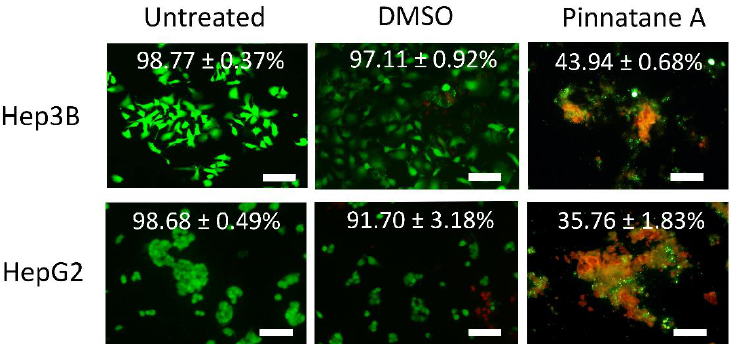
Figure 2. Pinnatane A induces cell death in Hep3B and HepG2 cell lines. A live/dead assay after treatment with pinnatane A and DMSO for 12 h. Green fluorescence denotes viable cells stained with calcein-AM, while reddish-orange fluorescence represents dead cells stained with ethidium homodimer. All results are expressed as a total percentage of viable cells from four random fields with mean ± standard deviation (SD) of three independent determinations. Scale bar represents 100 µ